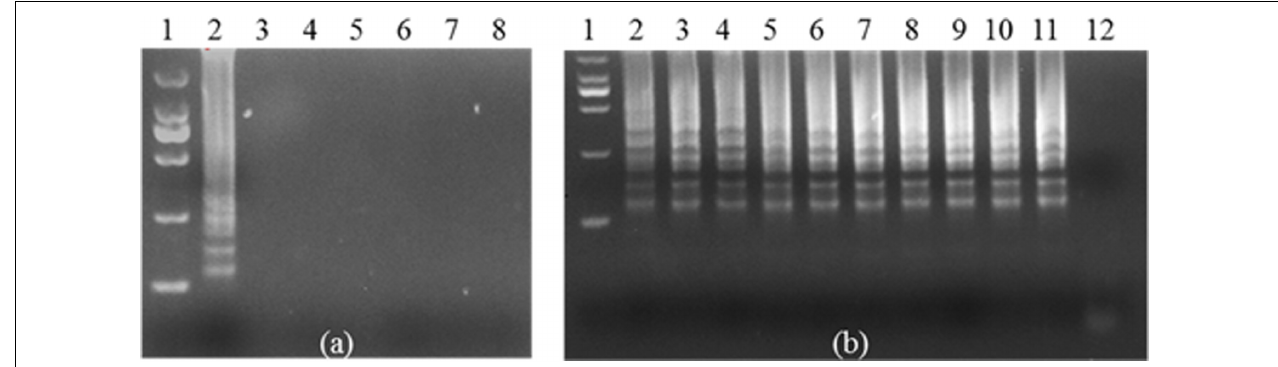
FIGURE 1 | Specificity and sensitivity of ipaH -LAMP assays using the genome of Shigella strains and the plasmid containing the ipaH gene of Shigella strains. (a) 3% agarose gel electrophoresis of the Shigella -templated LAMP Product; lane 1, 2000 bp DNA marker; lane 2, positive LAMP products; lane 3 to lane 7 represent LAMP reactions of genomic DNA of Escherichia coli , Staphylococcus aureus , Salmonella , Listeria , and Pseudomonas aeruginosa , and lane 8 is the reaction with nuclease-free water as a negative control. (b) The sensitivity assay. Lane 1, 2000 bp DNA marker. Lanes 2 through 11, positive plasmid used as template at concentration of 10 0 to 10 9 copies per reaction. Nuclease-free water was used as a negative control in lane 12.